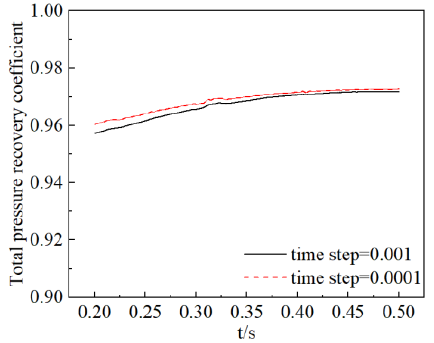
Figure 7. Calculation results of total pressure recovery coefficient at outlet of the inlet in two time steps of 0.2 to 0.5 s. steps of 0.2 to 0.5 s.